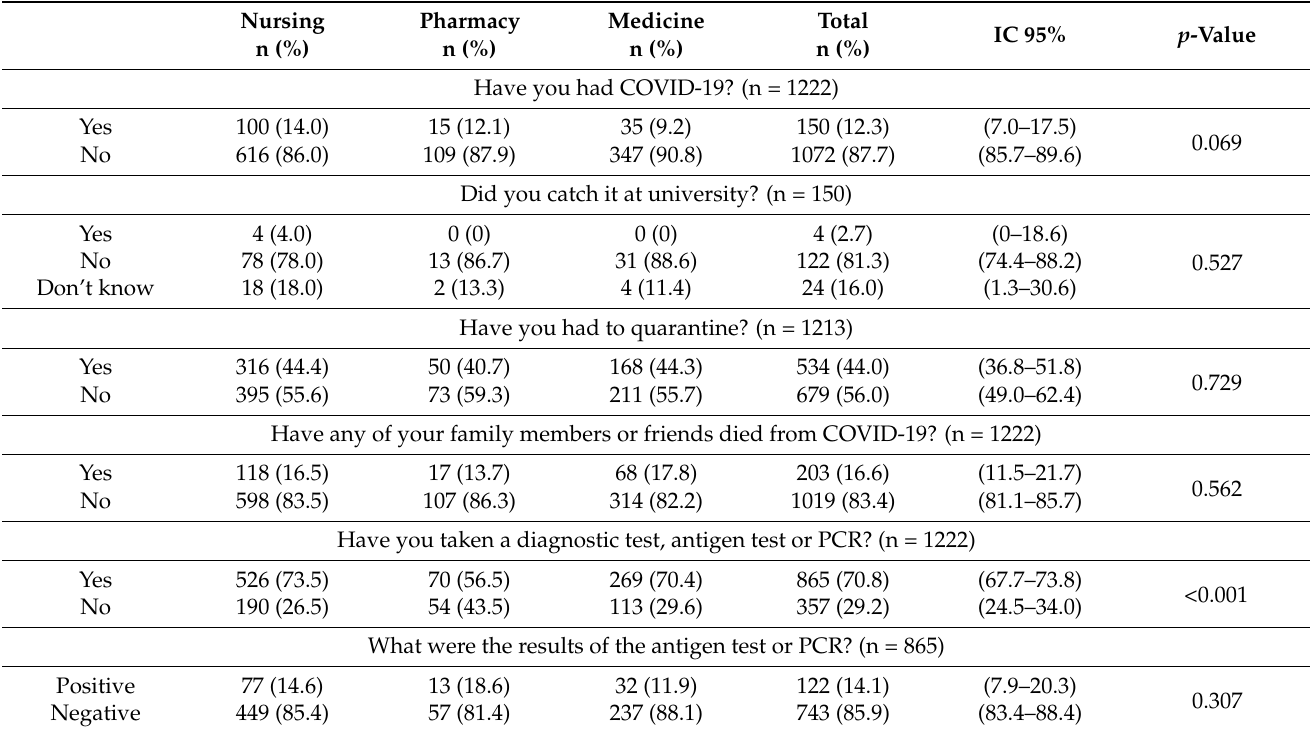
Table 2. COVID-19 disease in surveyed students. (n = 1222).